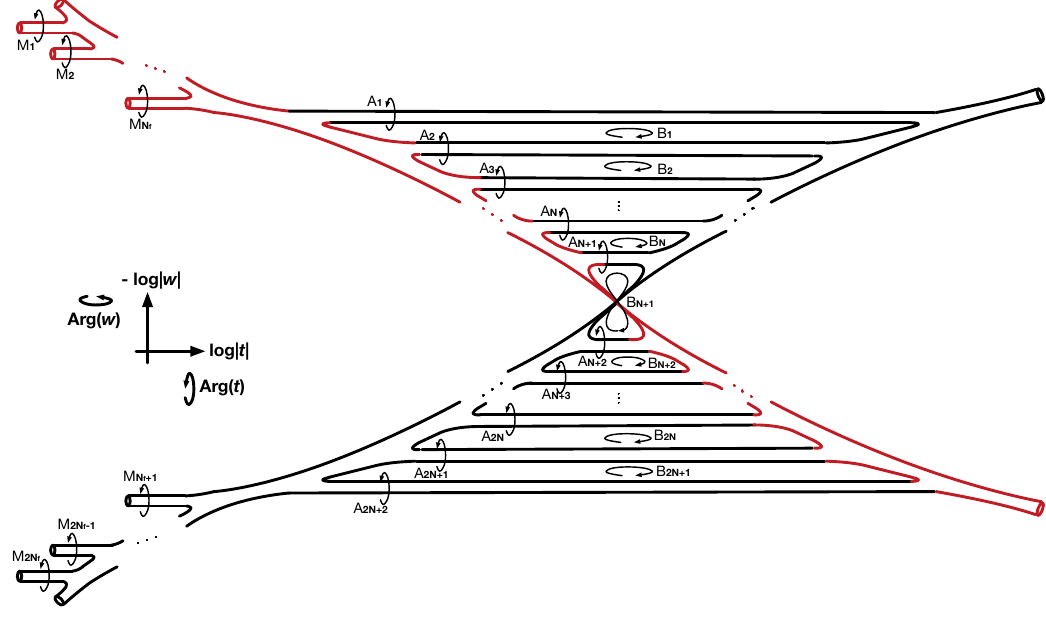
Figure 4 . Seiberg-Witten curve obtained by thickening the 5-brane web. A I , B I , and M i cycles are depicted. The red part is identified as one branch, on which t + ( w ) is